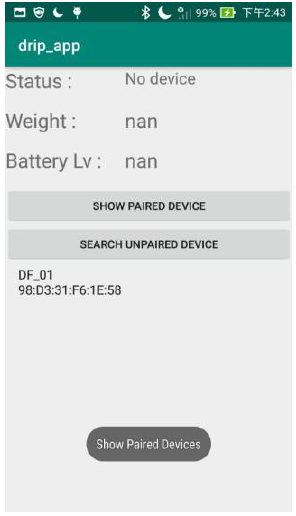
Figure 28. Android phone app application.